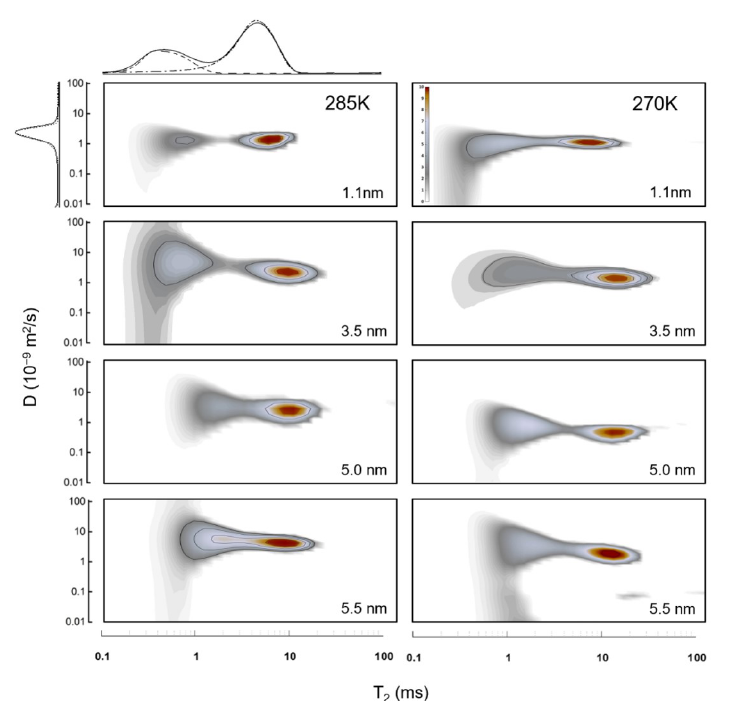
Figure 2. Two-dimensional (2D) 1 H NMR D–T 2 ef f contour plots of water inside CNT of sizes 1.1, 3.5, 5.0, and 5.5 nm at selected temperatures (270 and 285 K). Note that T 2 ef f denotes the effective transverse relaxation time, which includes the effects of diffusion. Two main T 2 ef f peaks are observed, corresponding to two different water groups (interstitial and nanotube water) as seen in the T 2 ef f projection for a 1.1 nm sample at 285 K. For better visualization, all signal intensities at 270 K are multiplied by 4. Reprinted from Reference [64], with the permission of AIP